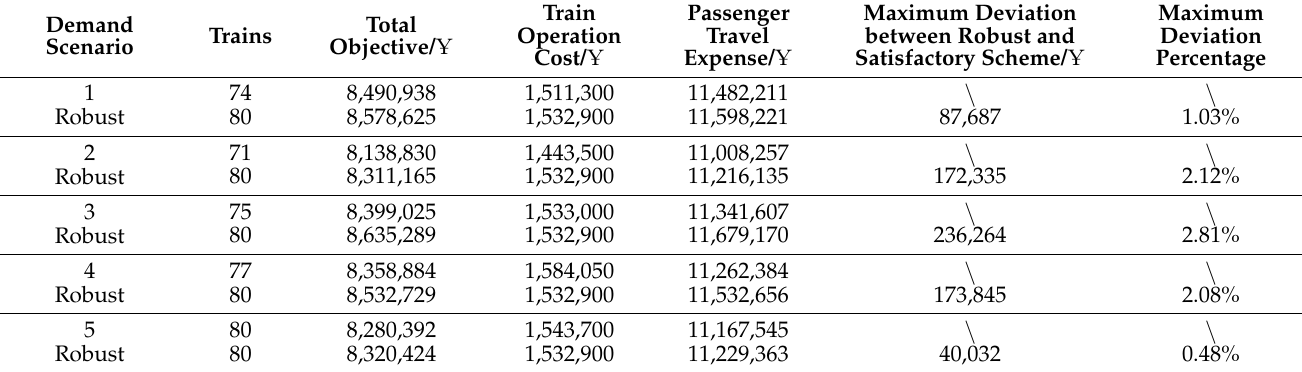
Table 4. Comparison between the robust scheme and the satisfactory scheme for each demand scenario.